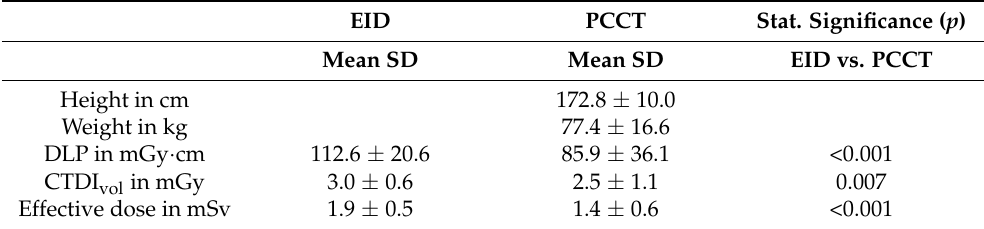
Table 4. Mean values with standard deviation (SD) regarding height, weight and different dose parameters as well as their associated p -values. Since height and weight were recorded during PCCT scans only, these parameters were adopted for the dose calculation of EID-CT scans as